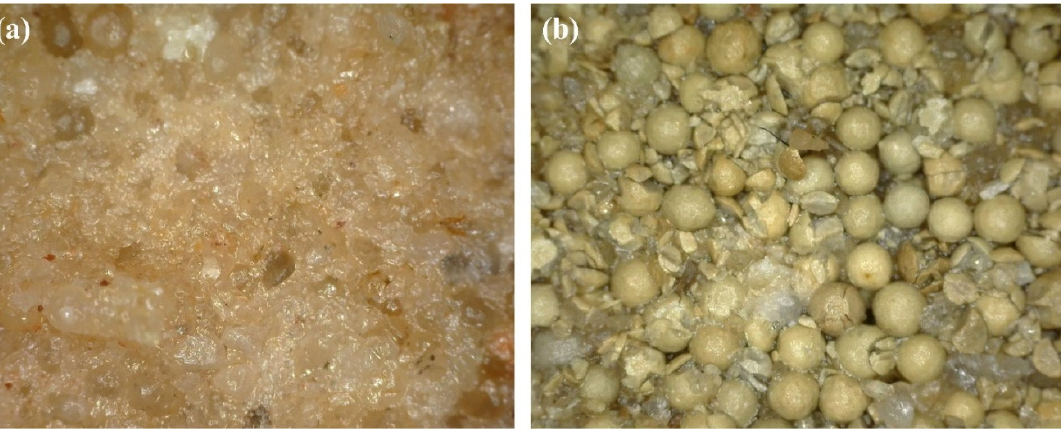
Figure 6. Crushing of proppant after fracture closure (( a ): sand proppant, ( b ): ceramic proppant) [122].